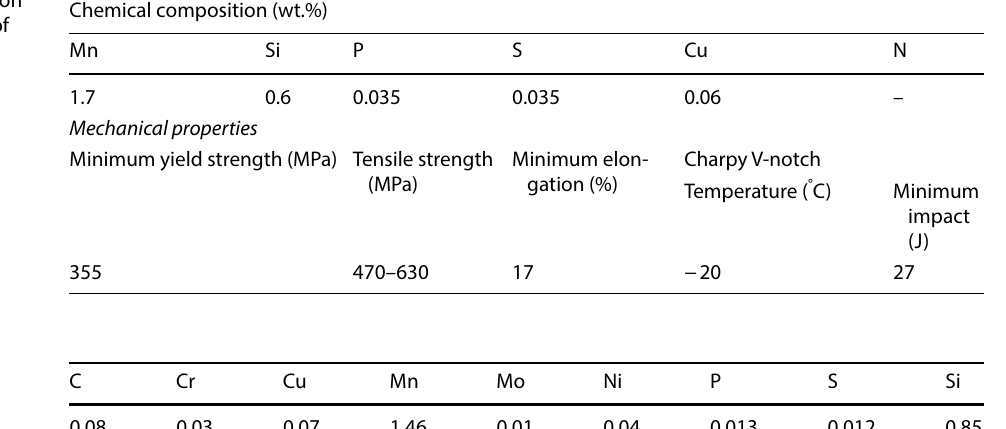
Table 2 Chemical composition and mechanical properties of base material (S355J2)